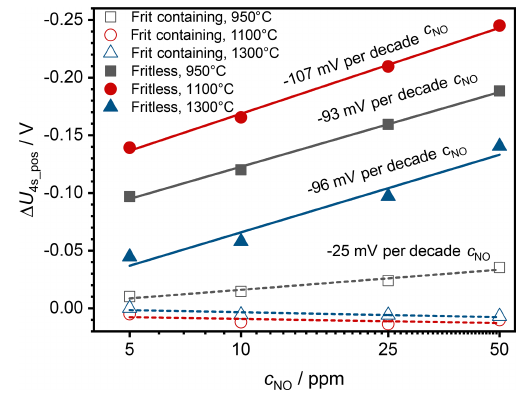
Figure 4. Sensor characteristics towards NO for different